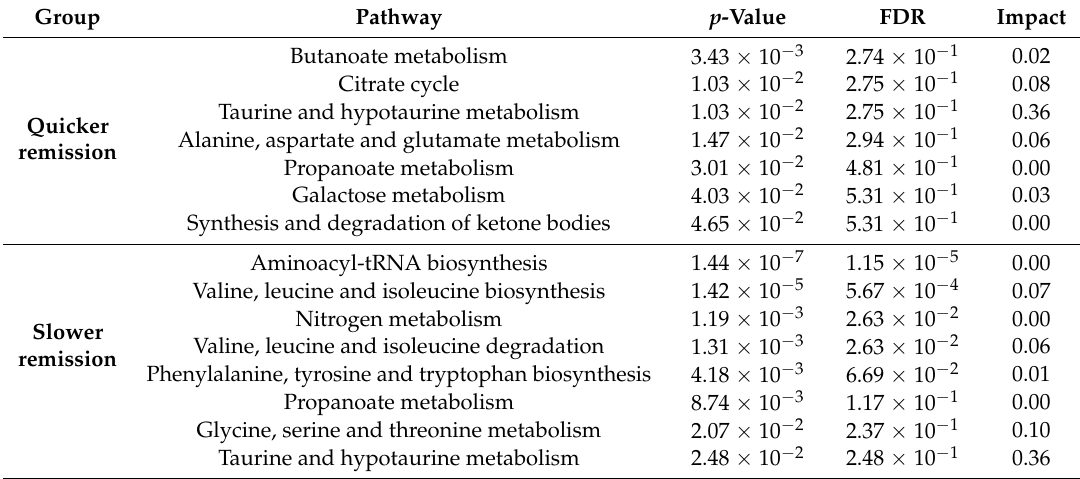
Table 5. Results (selected) from the Pathway